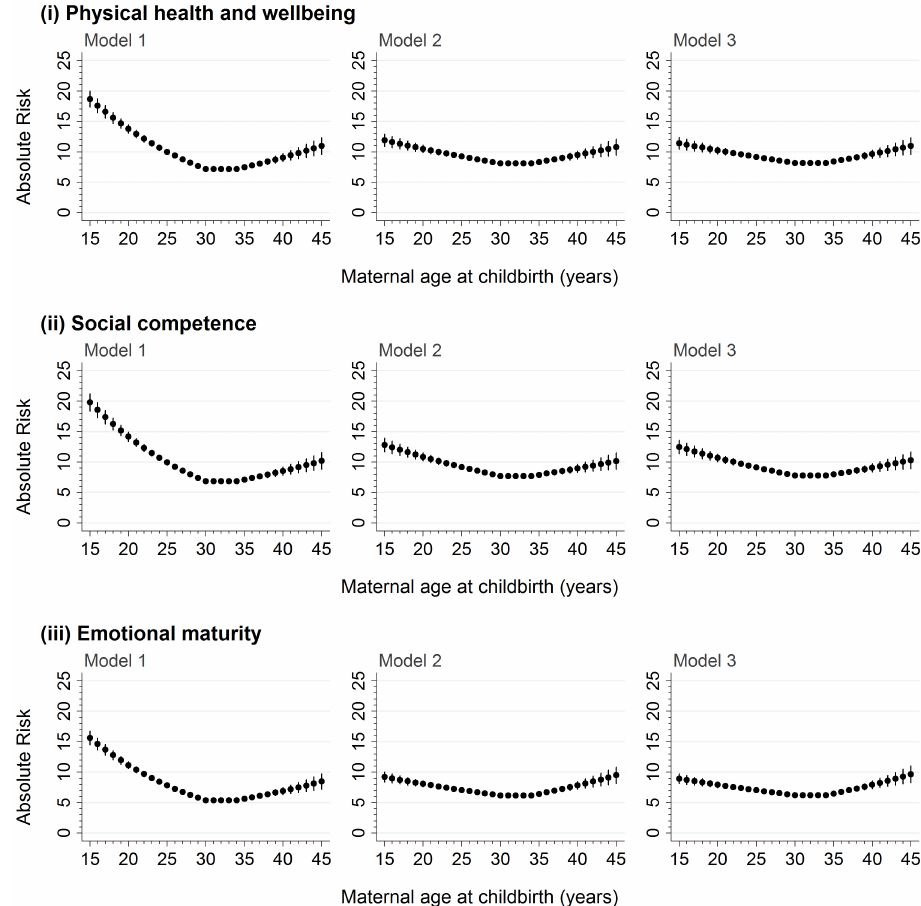
Fig 2. The absolute risk of developmental vulnerability on the physical health and well-being, social competence, and emotional maturity domains of the AEDC for every year of maternal age at childbirth between 15 and 45 years. Model 1 includes adjustment for the child’s age at school entry, sex, and AEDC year; in addition to the covariates included in Model 1, Model 2 adjusts for private health insurance/patient status, mother born in Australia/ overseas, mother partnered/single parent, mother’s parity, child’s Aboriginality, whether child speaks English as a second language, highest level of maternal school education, highest level of occupation of either parent, area-level disadvantage, and geographical remoteness; in addition to the covariates included in Model 2, Model 3 adjusts for antenatal care visit before 20 weeks gestation, smoking during pregnancy, and preschool/day care attendance in the year before school. AEDC, Australian Early Development